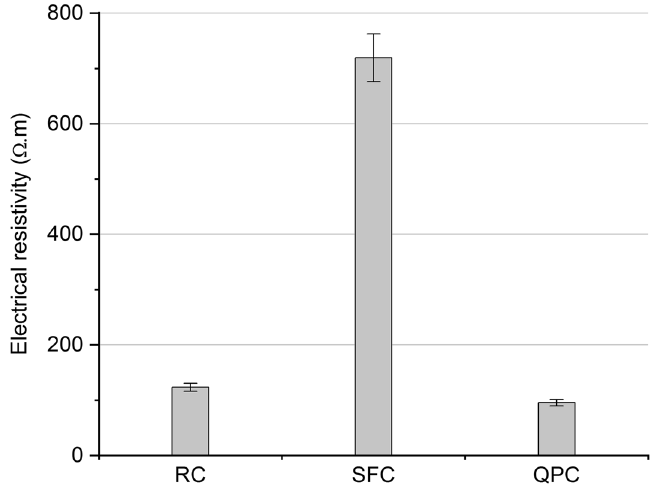
Figure 9. Volumetric electrical resistance of the RC, SFC and QPC at 300 days of curing.